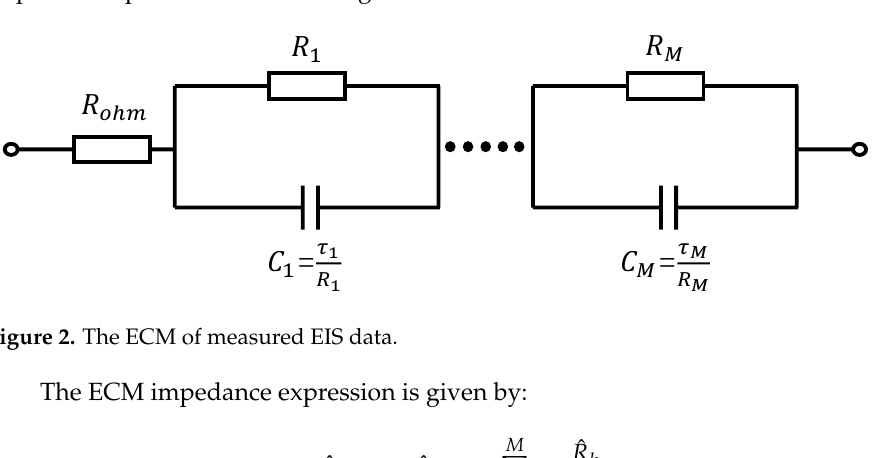
Figure 2. The ECM of measured EIS data. 𝑅𝑅 𝑀